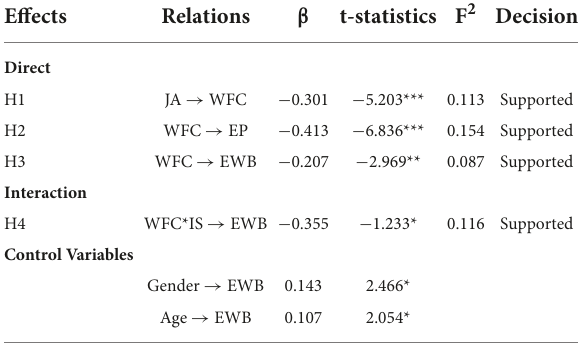
TABLE 3 Structural model assessment and hypothesis